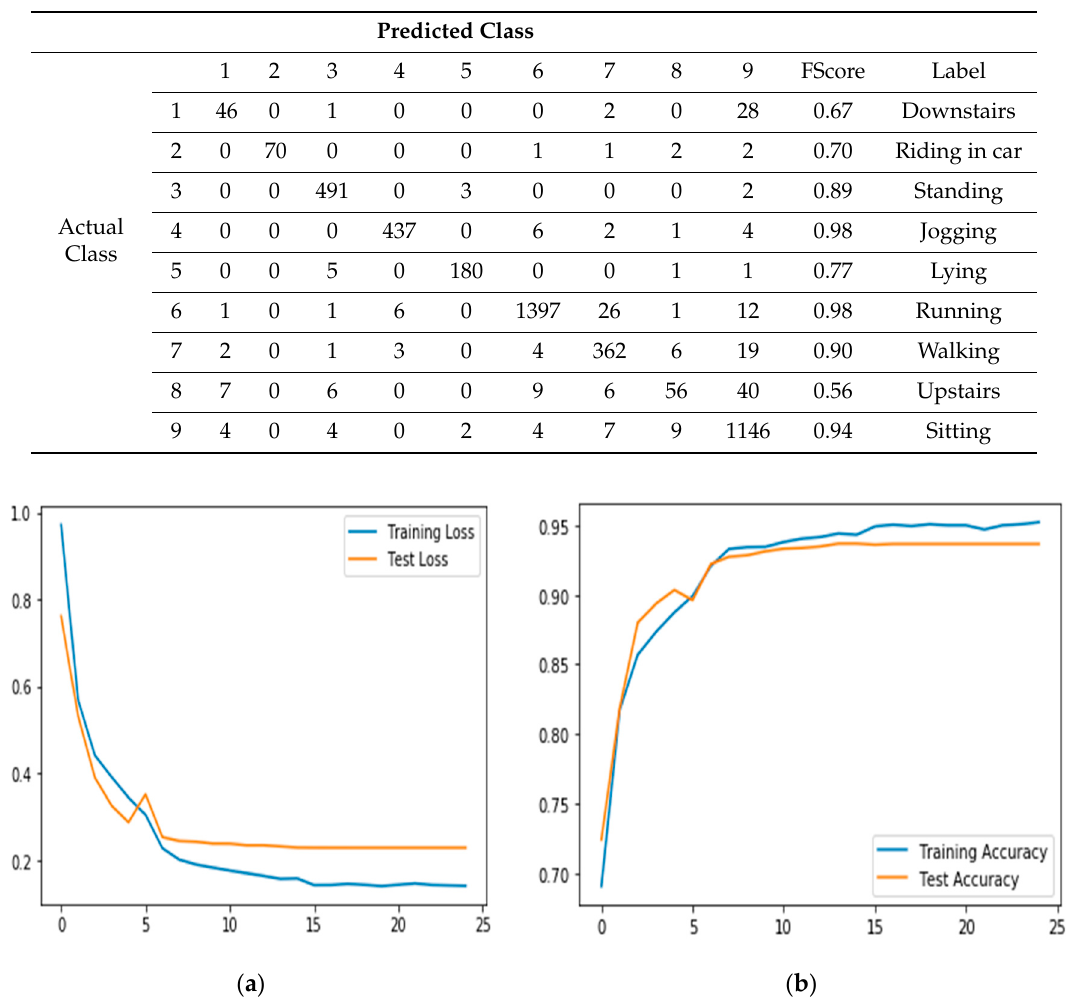
Figure 22. Recognition error/loss ( a ) and recognition accuracy ( b ) of inertial sensing data.